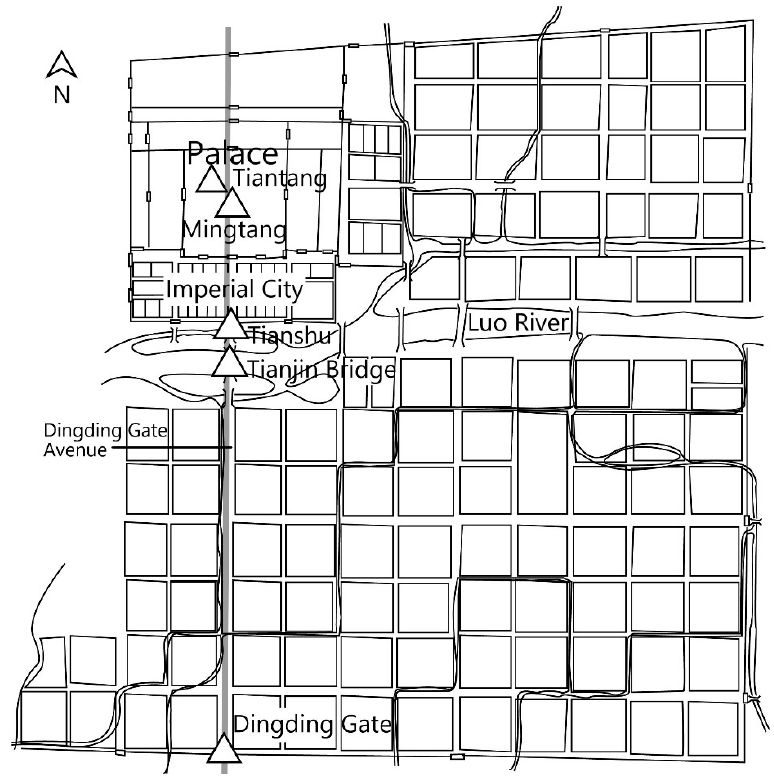
Figure 5. Schematic diagram of the locations of the main ritual buildings showing Buddhist influences in Luoyang. 20